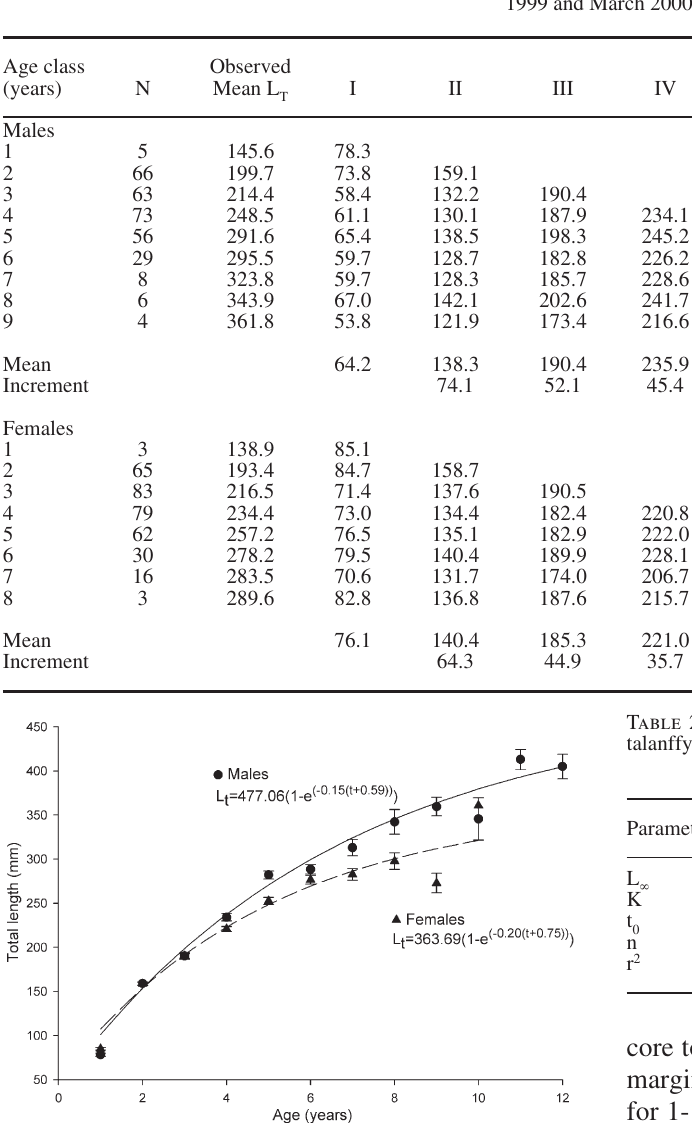
Fig . 7. – von Bertalanffy growth curves derived from back-calculat- ed age-at-lengths for male and female H. didactylus sampled in the Bay of Cádiz between March 1999 and March 2000 .